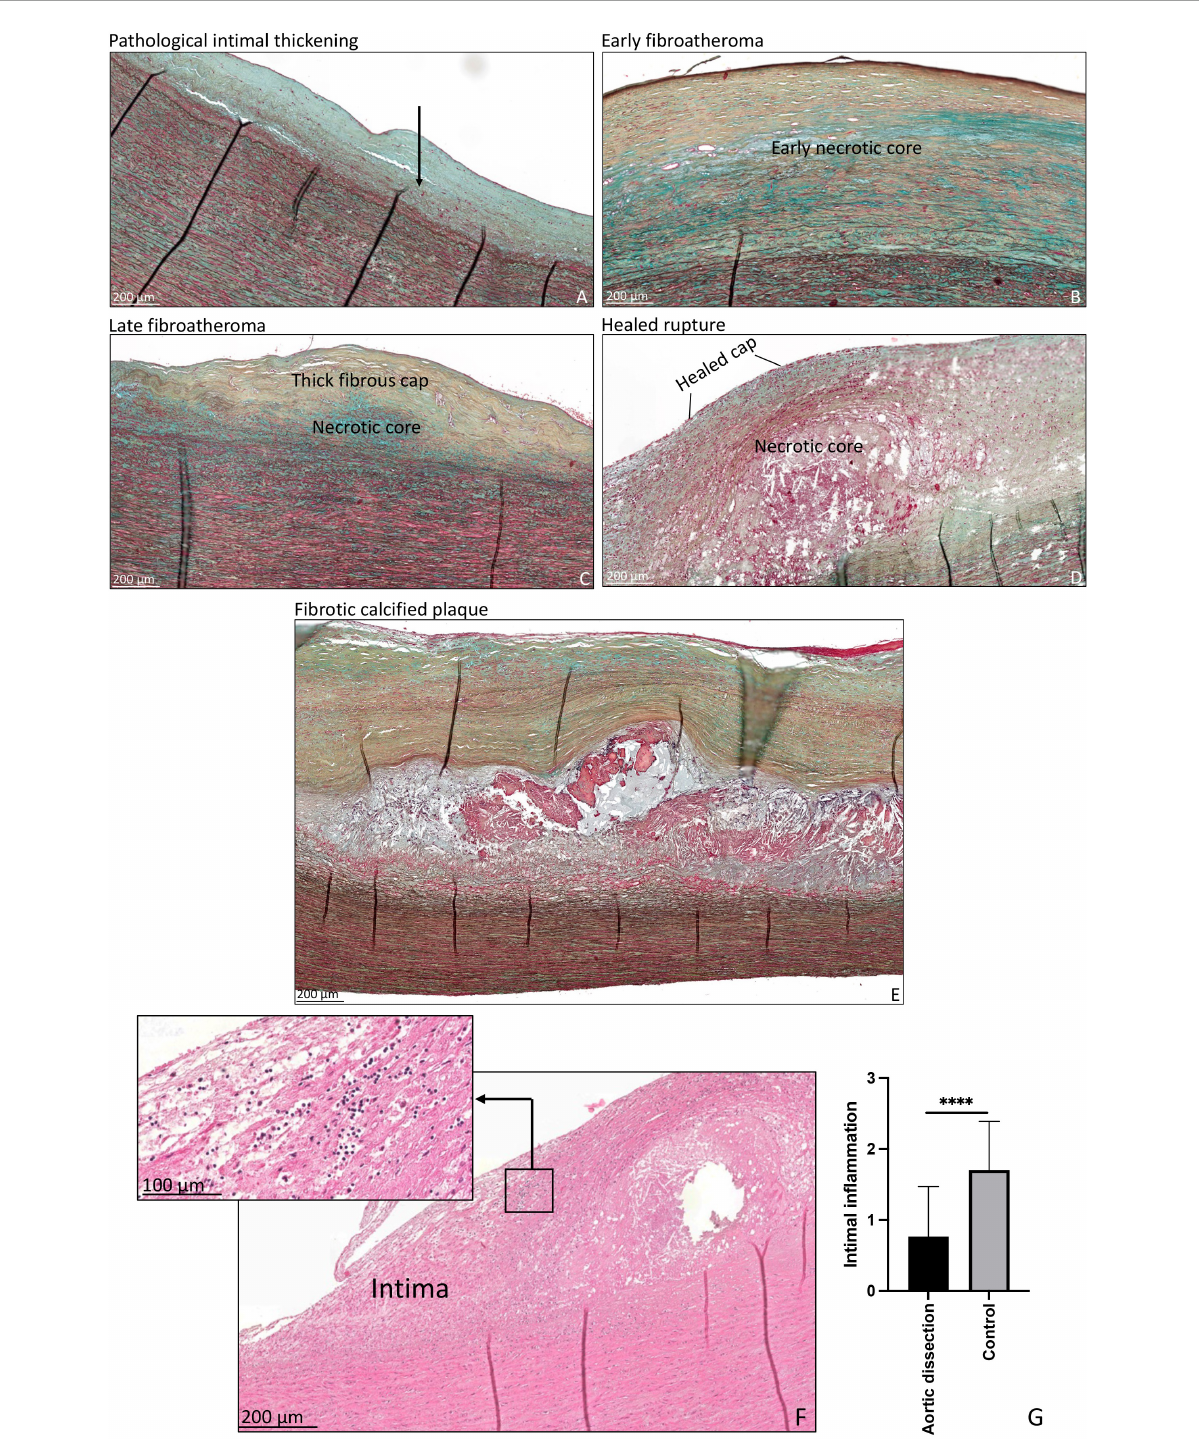
FIGURE4 Transverse histologic section (4 µ m) of control aortic specimen, stained with MOVAT pentachrome (A–E) and hematoxylin eosin (F) staining. (A) Shows pathological intimal thickening, lipid pools are seen deep within the intima near the intimal medial border with overlying vascular smooth muscle cells (black arrow). (B) Shows early fibroatheroma, with an early necrotic core. (C) Shows late fibroatheroma with a thick fibrous cap overlying the necrotic core. Healed rupture is seen in panel (D) and a fibrotic calcified plaque in panel (E) . Intimal inflammation is seen in panel (F) , the insert demonstrates a detail of the inflammatory cells. The qualitative amount of inflammatory cells was significantly higher in the control group as compared to the type A aortic dissection patients ( p < 0.0001) (G) . ∗∗∗∗ p < 0.0001. Scale bar shown in the